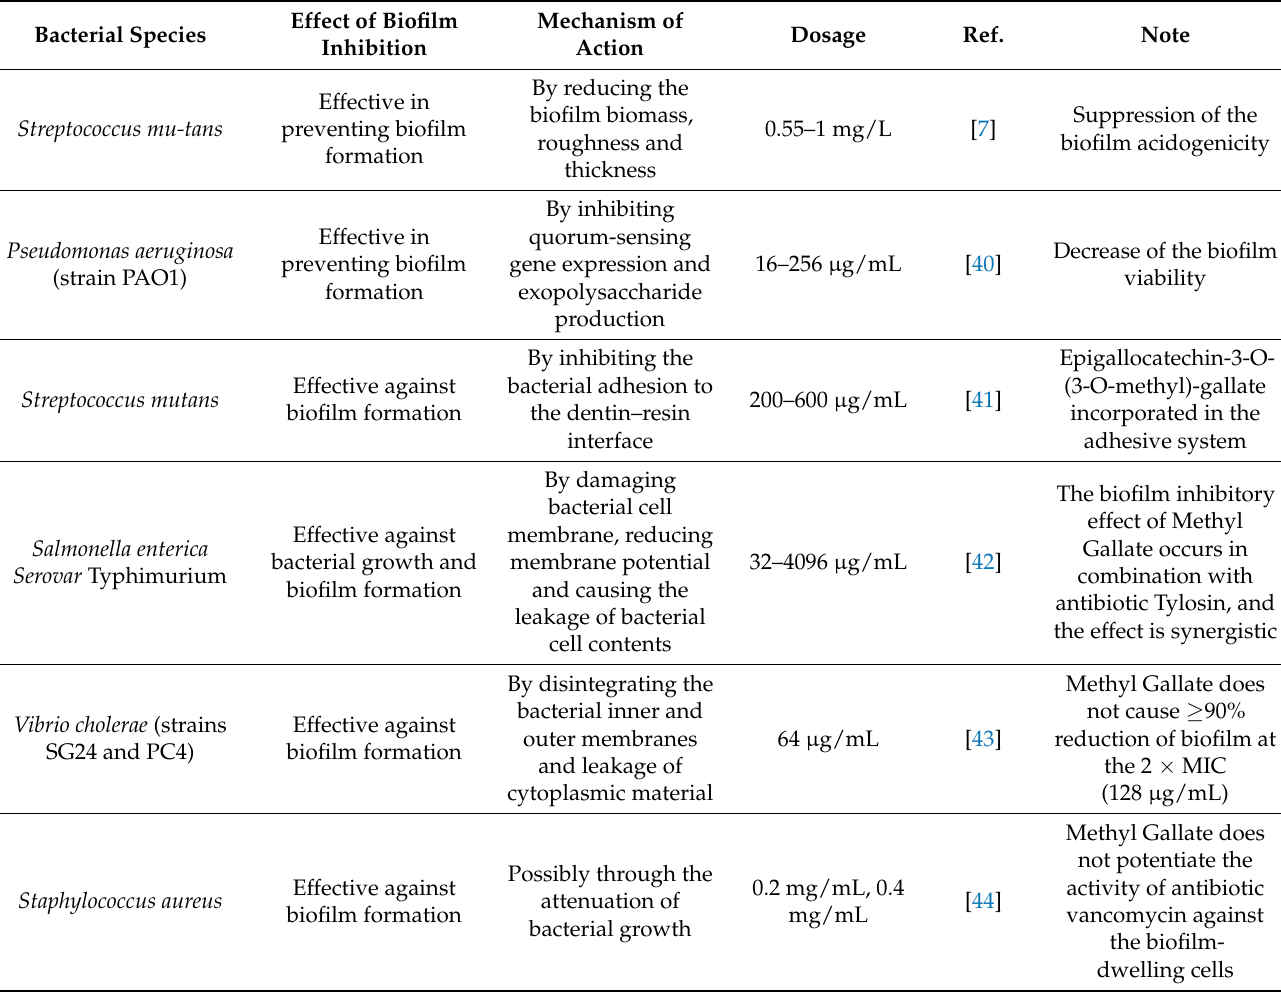
Table 2. Methyl Gallate inhibition of biofilm formation tested on bacterial species, and its suggested mechanisms of